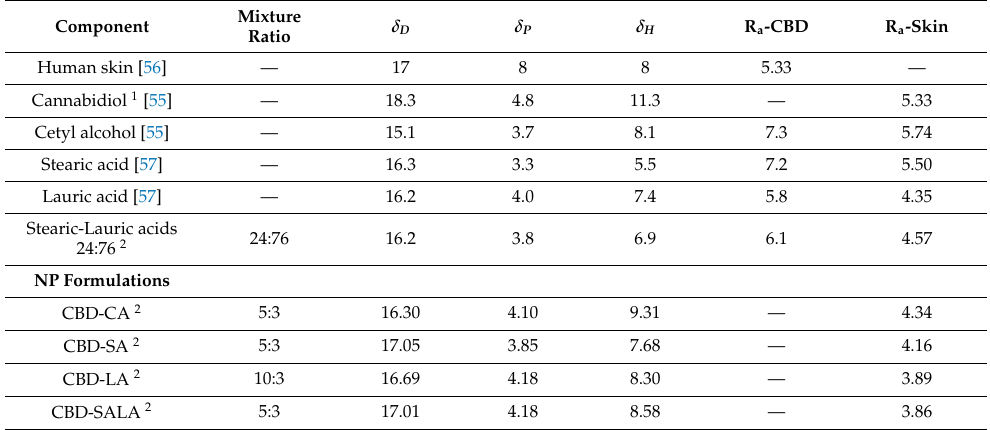
Table 3. Hansen solubility parameters (HSP) and the δ values of human skin, LSNs, and their